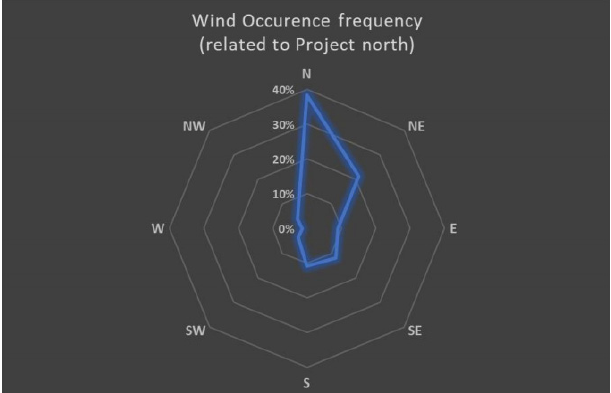
Figure 5. Summarized wind occurrence frequency according to Project North. Due to the geometrical characteristics, the FPSO system was divided into different monitored areas as detailed below: (1) Hull Deck, (2) Process Module 2-1st Deck (PR 2_1st), (3) Process Module 2-2nd Deck (PR 2_2nd), (4) PD-Process Deck (Desulfurization Module and Fuel Oil), (5) Process Module 1-1st Deck (PR 1_1st), (6) Process Module 1-2nd Deck (PR 1_2nd), (7) Offloading Starboard, (8) Offloading Portside, (9) Firewall, (10) Power-Generation Module, (11) Electrical Module 1, (12) Electrical Module 2, (13) Utility Module, (14) Living Quarter, (15) Helideck, (16) Base of Flare Tower, (17) Closed Drain Area, (18) Flare KO Drum Area, (19) Risers, (20) Topside Deck, (21) Crane Portside, and (22) Crane Starboard. Figure 6 shows the regions defined for the probabilistic explosion and fire analysis.